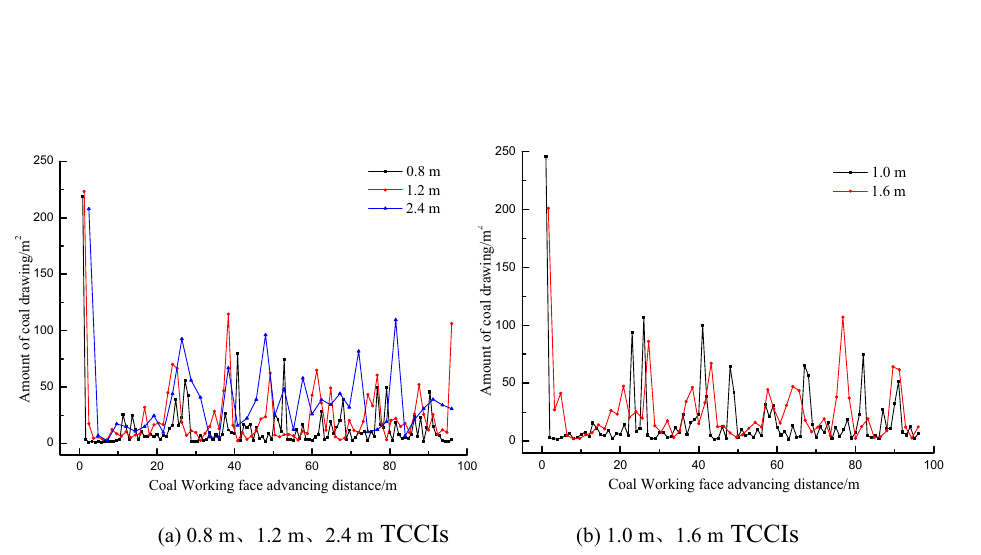
Figure 11. Statistics of top coal recovery amount of each step in different coal-drawing interval under 20.0 m top coal